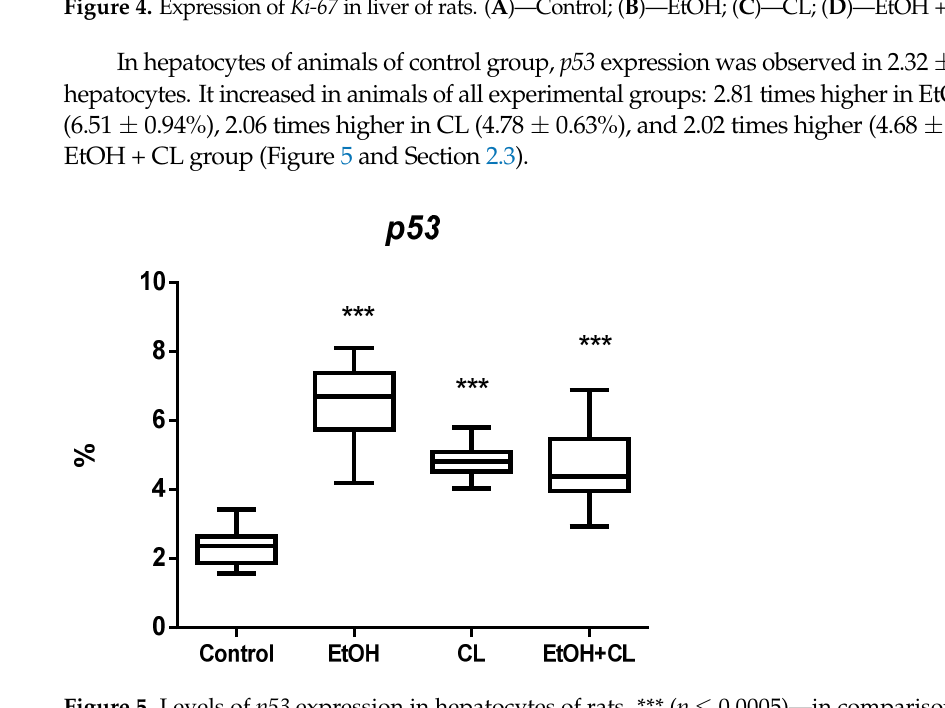
Figure 5. Levels of p53 expression in hepatocytes of rats. *** ( p ≤ 0.0005)—in comparison with the parameters of animals of the control group.